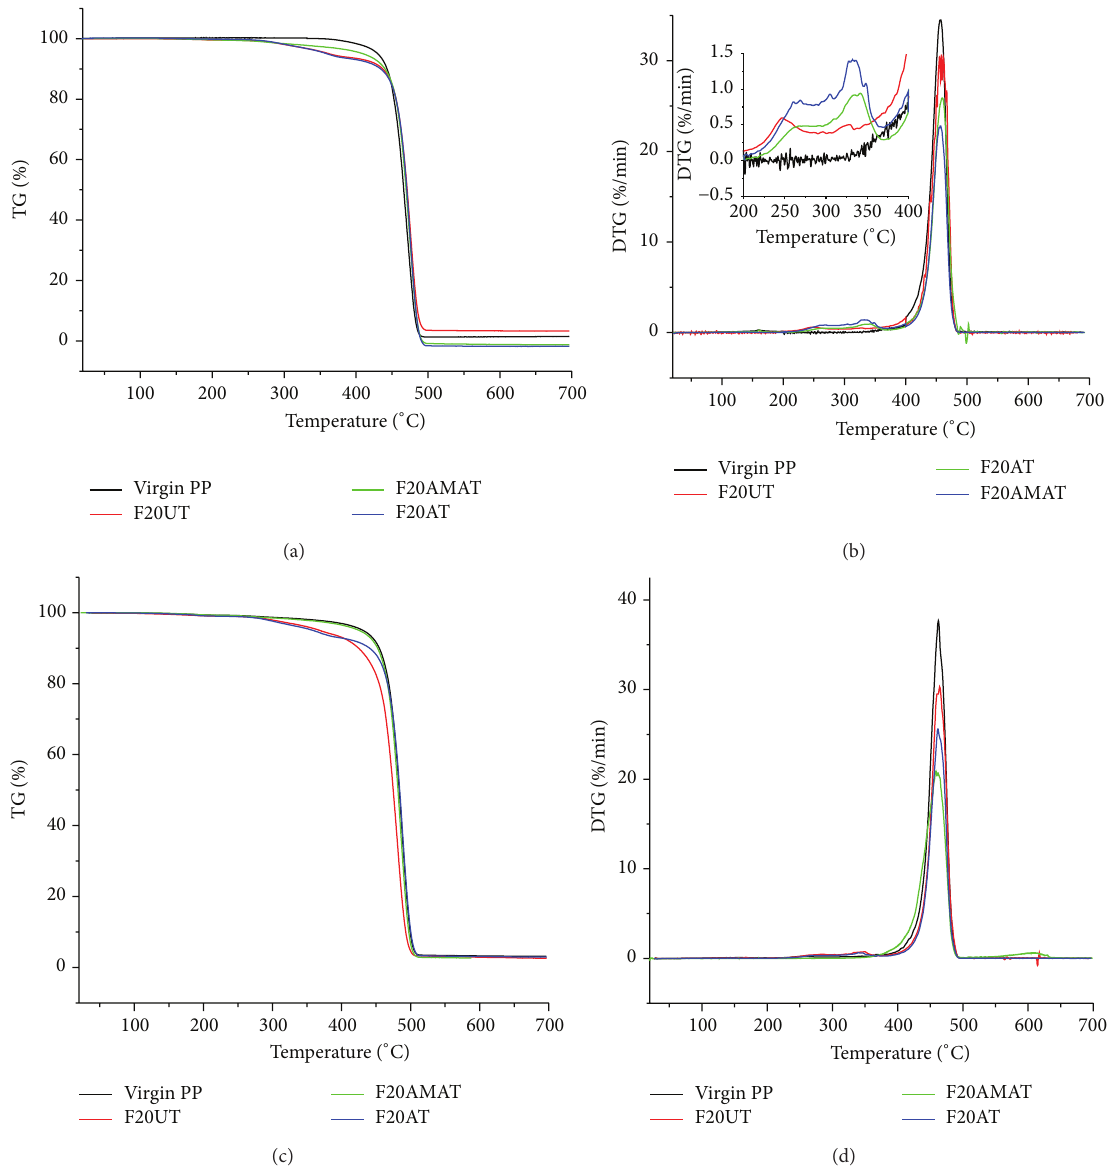
Figure 2: Thermal degradation behavior of the composites: ((a), (b)) before aging and ((c), (d)) after aging.